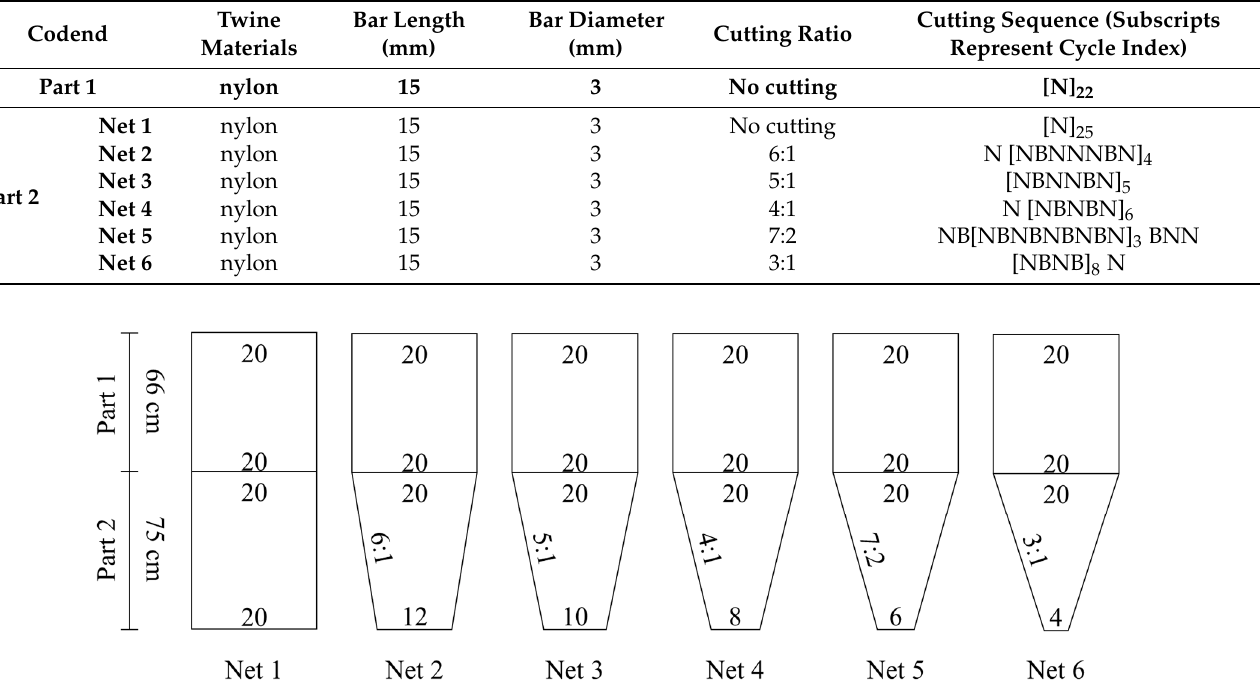
Table 1. Specifications for each netting panel of codend.